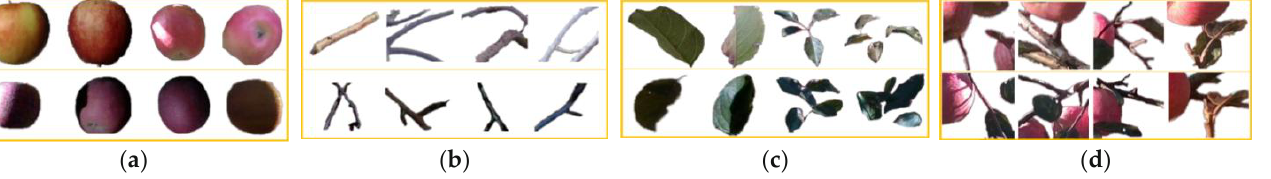
Figure 5. Various occlusion elements under high and low illuminations: ( a ) fruit occlusion elements under high and low illuminations; ( b ) branch occlusion elements under high and low illuminations; ( c ) leaf occlusion elements under high and low illuminations; ( d ) combined leaf, branch, and fruit occlusion elements under high and low illuminations.